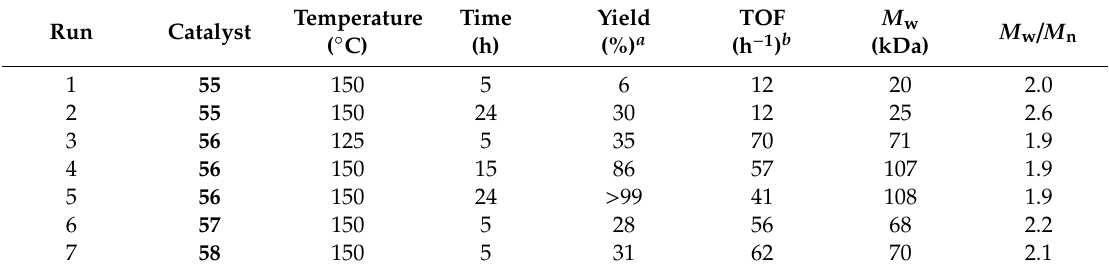
Table 6. ROP of β -BL catalyzed by 54–57